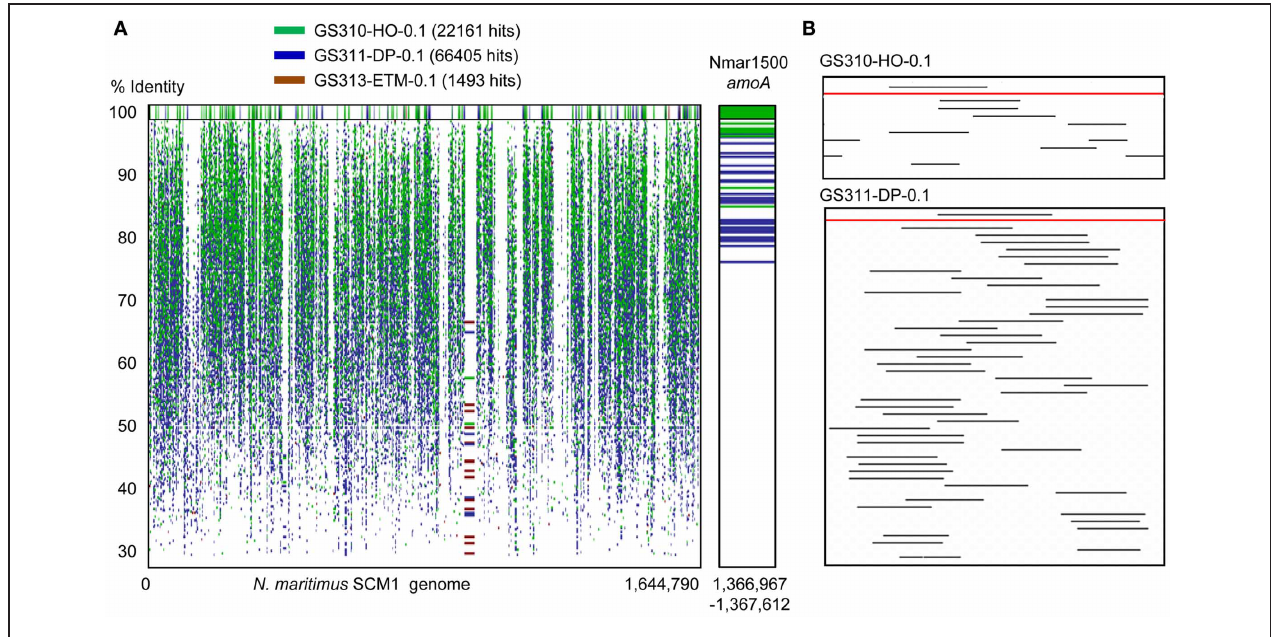
ETM 0.1- μ m size metagenomes are shown in green, blue and brown, respectively, with the corresponding hit numbers in brackets. The right panel is a blown up section of the recruitment plot containing the N. maritimus amoA gene encoding the active subunit of the archaeal ammonia monooxygenase enzyme. (B) Alignment of 16S rRNA hits (with dereplication to < 97%) from two 0.1- μ m metagenomes of the hypoxic (upper) and deep (lower) samples aligned against the N. maritimus 16S rRNA gene (the red